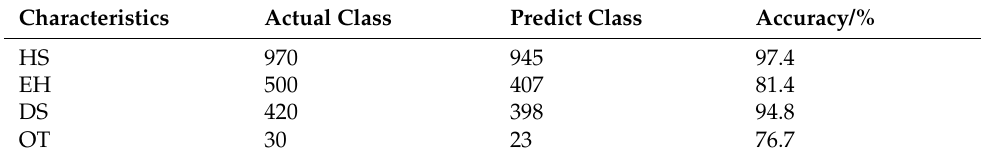
Table 3. Identification results and